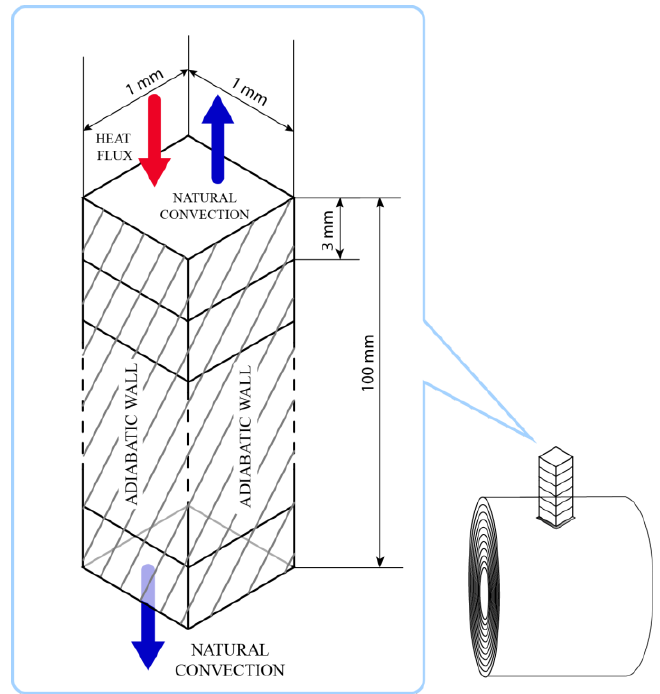
Figure 6. Finite elements method (FEM) model geometry, thermal loads, and boundary conditions.